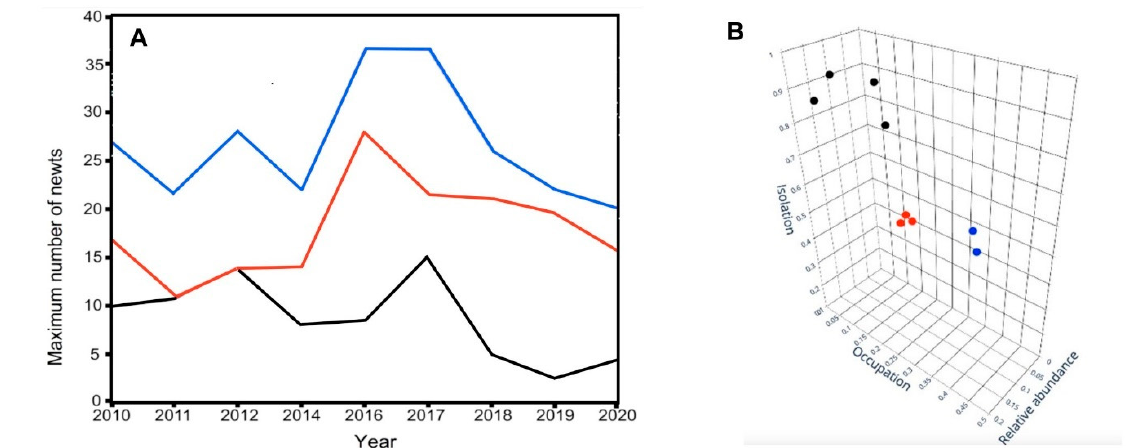
Figure 10. ( A ): Maximum number of newts observed at night for every year. Lack of data during 2013 and 2015 is due to the severe drought affecting the populations that prevented us from gathering enough data (black: eastern populations; red: western populations; blue: total). ( B ): Tridimensional plot of the values for each Montseny brook newt population on three indicators: relative abundance (number of newts/m). occupation (percentage of stream occupied by the population) and isolation (dendritic index between pairs of geographically close populations). Black dots show the tridimensional position of populations with high risk of extinction given their high levels of isolation and low percentage of stream occupation. The best combination of favorable indicators, which are high connectivity, stream occupation and relative abundance, are found only in two populations marked with blue dots, whereas three populations (red dots) showed intermediate risk of extinction.